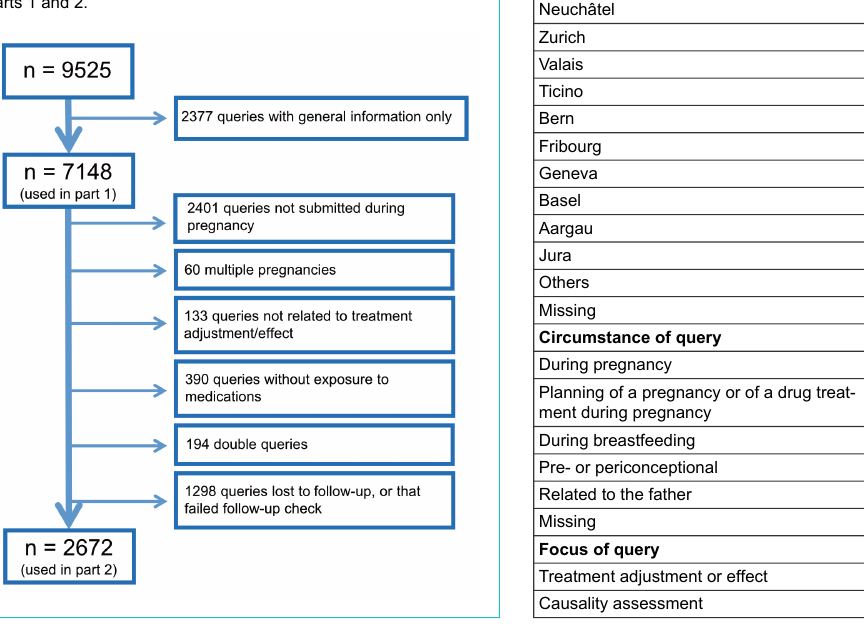
Figure 1: Queries flow chart used to obtain sample analysed in parts 1 and 2.